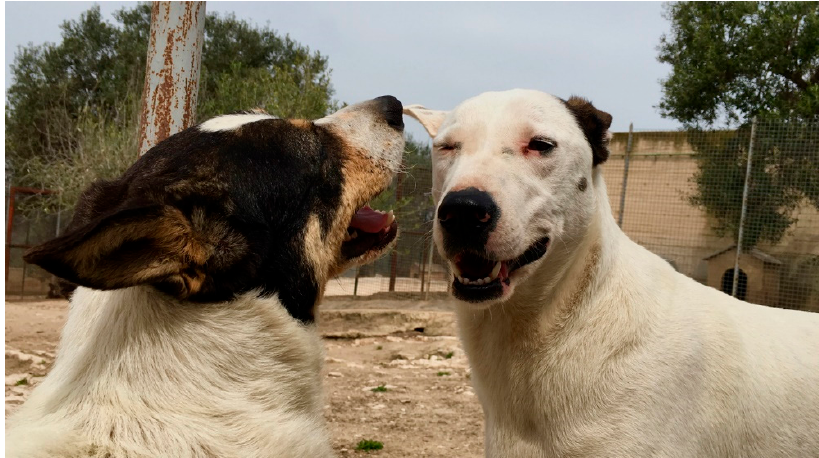
Figure 4. In this photo two, relaxed facial expressions are shown. The mouths are not tense, the looks are not direct, and the proximity tells us that the two dogs have a good relationship.